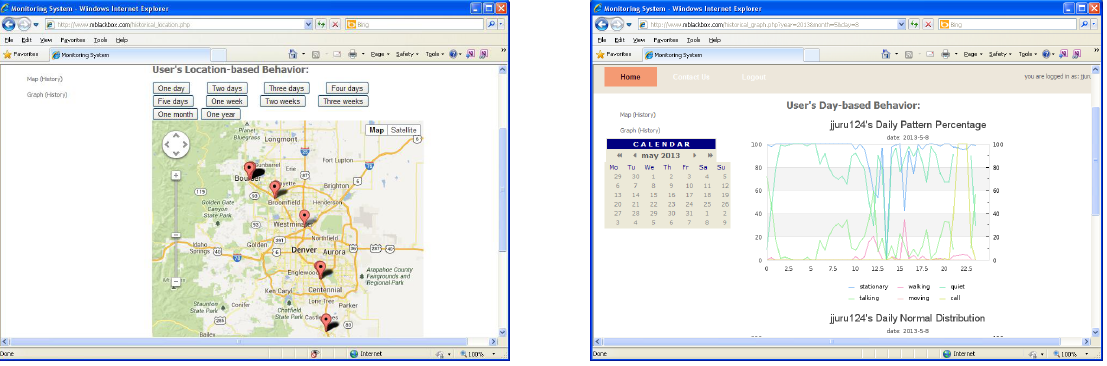
Figure 8. Web server using MongoDB. ( left ) A graphical map; ( right ) A multiple line